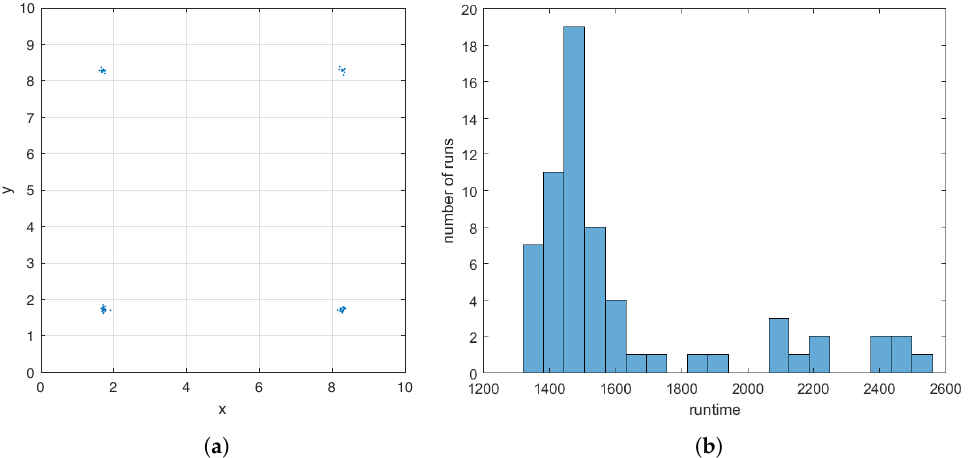
Figure 5. The estimate θ † found by Step 1 of the hybrid method and the runtime of this step as the seed of the random number generators varies for the case of a single helix. The flow meter is (7) with W = 10. Step 1 is repeated sixty-four times and a different seed is used each time. ( a ): Clustering of the sixty-four θ † ’s around the four maximizers of f ( θ ) . ( b ): Histogram of the sixty-four runtimes.